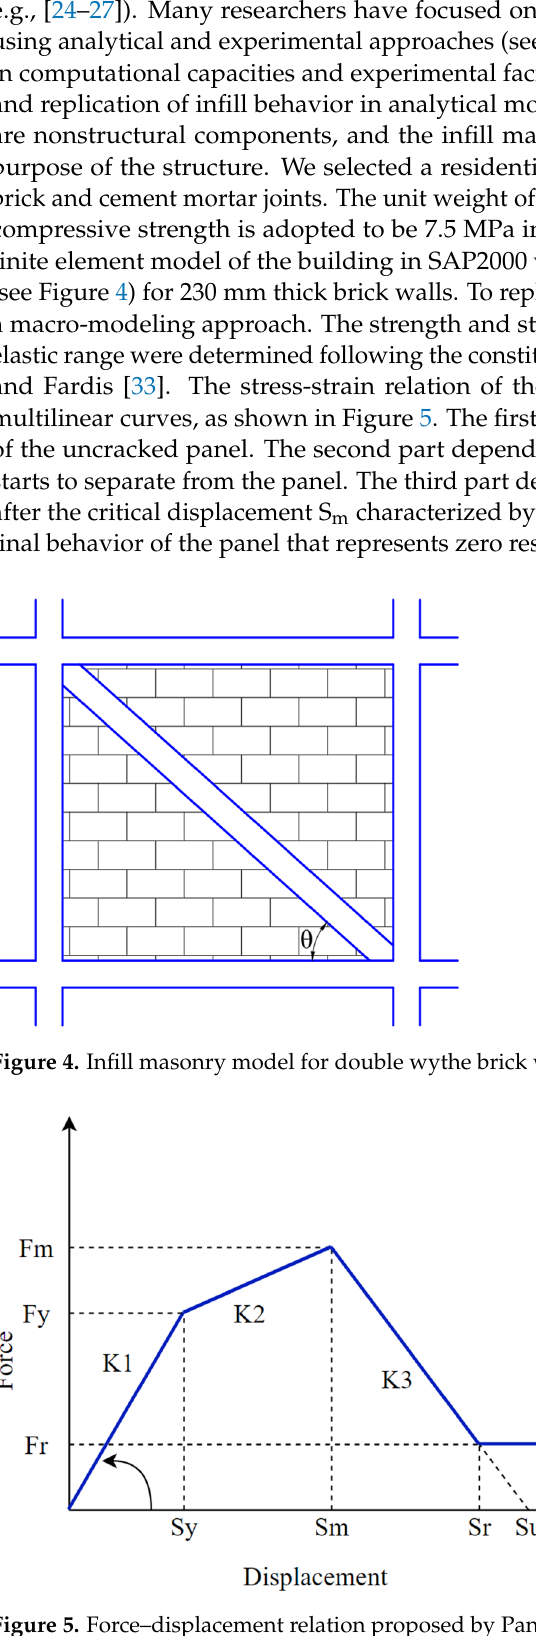
Figure 5. Force–displacement relation proposed by Panagiotakos and Fardis [33] for infill walls.